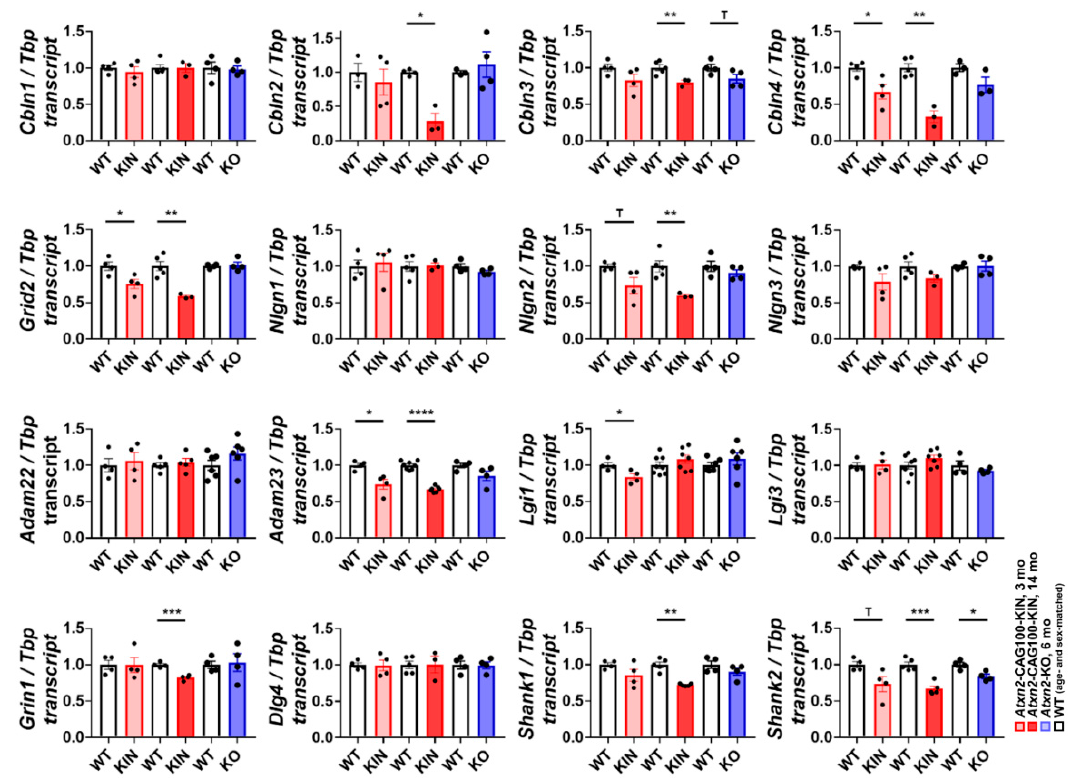
Figure 7. Expression analyses of synaptic structure, transmission and dendrite morphology factors. In Atxn2 -CAG100-KIN cerebellum throughout disease course at 3 mo and 14 mo of age and in Atxn2 -KO cerebellum, transcript levels of Cerebellin isoforms ( Cbln1-4 ), ionotrophic glutamate receptor δ 2 ( Grid2 ) and Neuroligin isoforms ( Nlgn1-3 ) were examined as extracellular and postsynaptic interactors of Neurexins in maintaining synaptic integrity. The structural bridge of glutamatergic synapses consisting of Adam22 , Adam23 , Lgi1 and Lgi3 , together with ionotrophic glutamate receptor NMDA type 1 ( Grin1 ) involved in synaptic transmission, post-synaptic density markers PSD95 ( Dlg4 ) and Shank isoforms ( Shank1-2 ) were also quantified throughout disease course by RT-qPCR. Student’s t -test with Welch’s correction; 0.05 < p < 0.1 T , p < 0.05 *, p < 0.01 **, p < 0.001 ***, p < 0.0001 ****. Further information regarding individual fold changes and p -values can be found in Supplementary Table